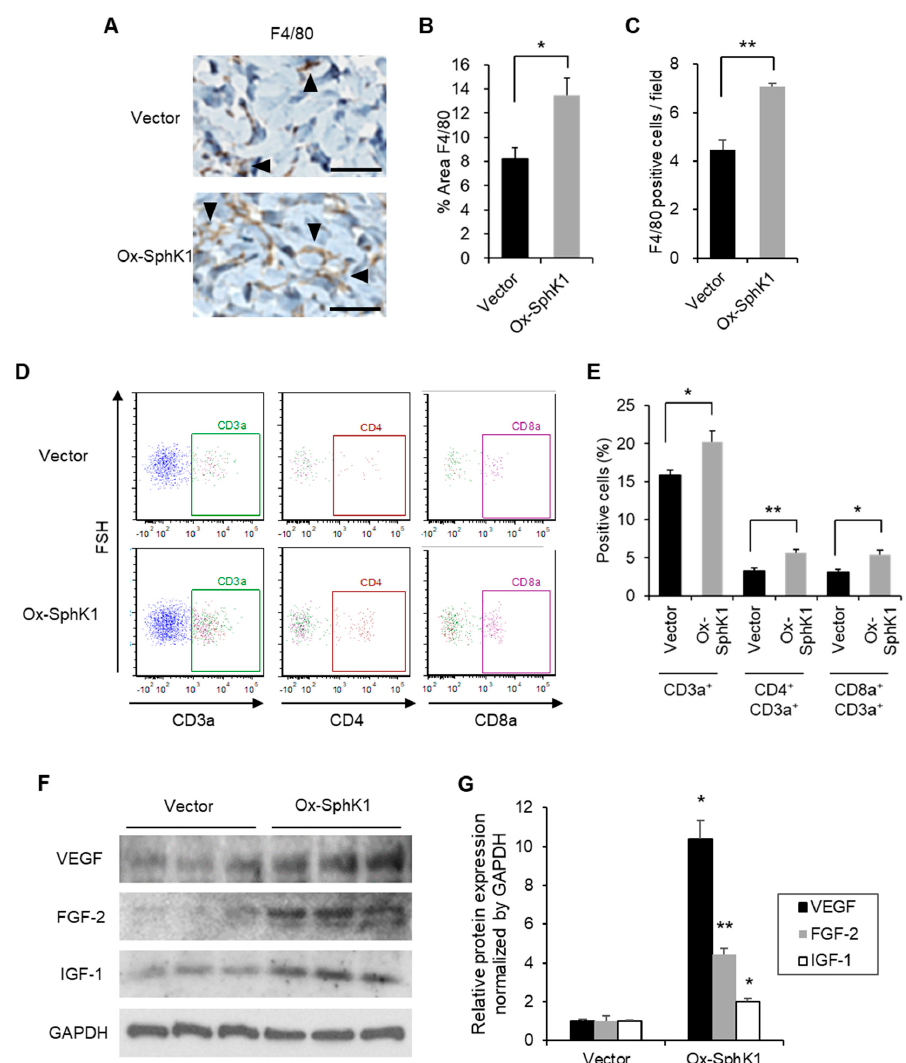
Figure 5. Effect of SphK1 overexpression on inflammatory cell recruitment and enhanced